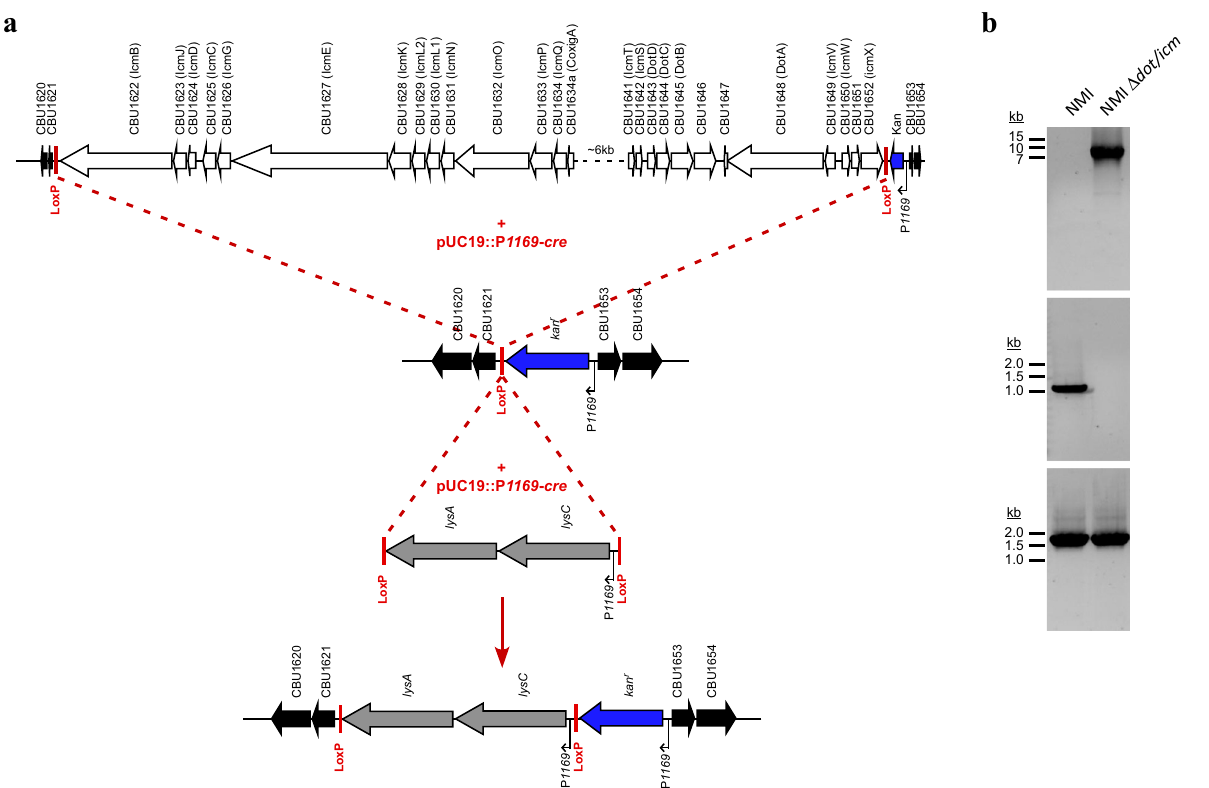
Fig. 1 Construction of C. burnetii NMI Δ dot/icm . Cre- lox mediated deletion of the 32.5 kb dot/icm locus ( cbu1622 – cbu1652 ). a Schematic outlining the replacement of the dot/icm locus with kan r and lysCA cassettes. A four-step Cre- lox strategy was used. Step 1 and 2 involved inserting loxP sites 5 ′ and 3 ′ of CBU1622 and CBU1652, respectively, using homologous recombination. Step 3 involved Cre mediated recombination between loxP sites resulting in deletion of the dot/icm locus. In step 4 Cre- mediated insertion of a lysCA cassette fl anked by loxP sites into the single loxP site adjacent to kan r was conducted to aid in cloning of the mutant. The location of loxP sites is denoted. b Agarose gels showing PCR product con fi rmation of deletion of the dot/icm locus and clonality of the mutant. The upper panel shows PCR products using primers fl anking the dot/icm locus. NMI template DNA produced no band due to the size of the expected product (41.7 kb) while NMI Δ dot/icm template DNA produced a band of the expected size (9.1 kb). The middle panel depicts lack of ampli fi cation of CBU1628 via gene